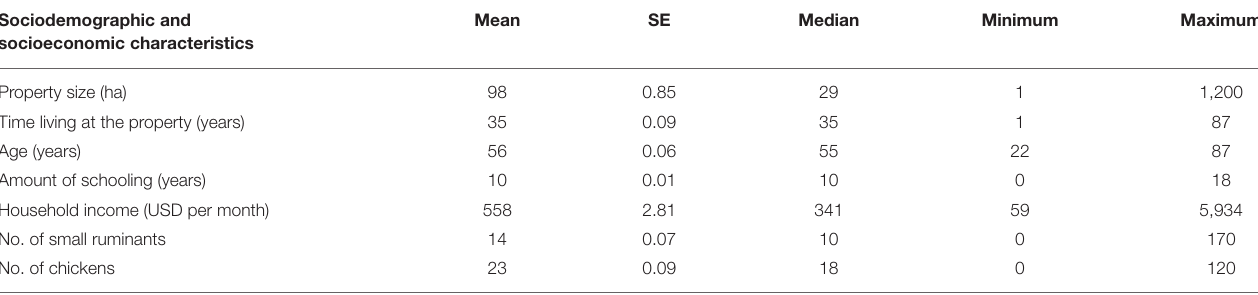
TABLE 1 | Sociodemographic and socioeconomic characteristics of questionnaire respondents living within the Araucanía region of southern Chile ( N = 233). Sociodemographic and Mean SE Median Minimum Maximum socioeconomic characteristics Property size (ha) 98